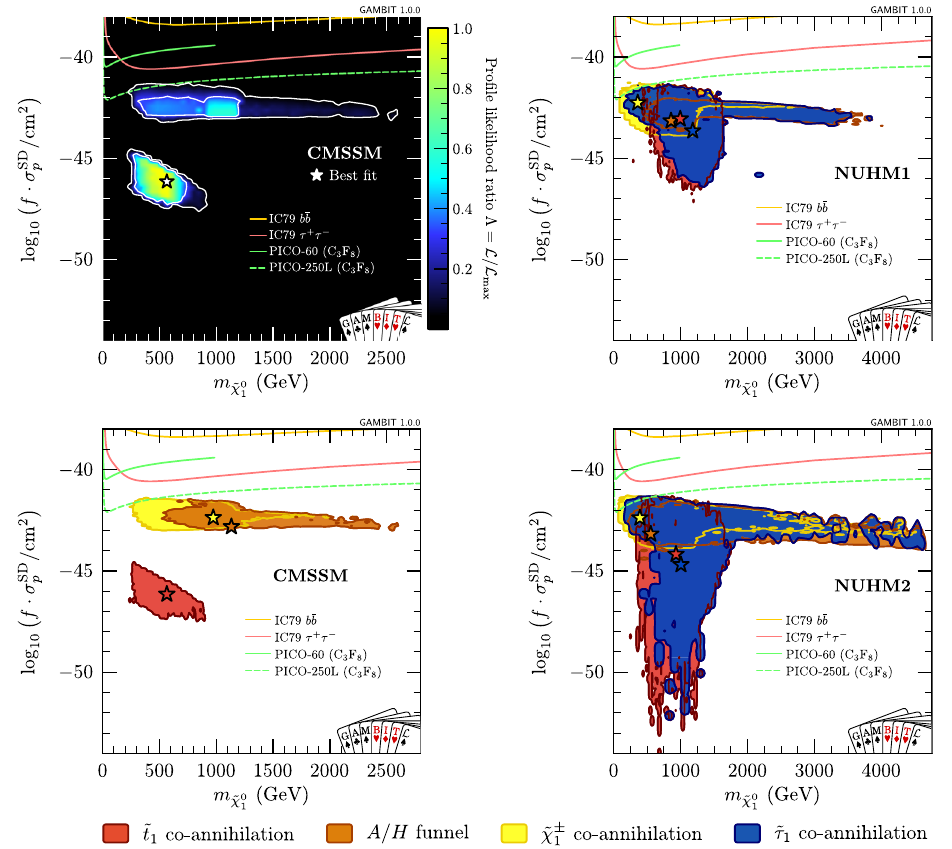
Fig. 20 The spin-dependent neutralino-proton cross-section. Upper left: Profile likelihood in the CMSSM. Bottom left: Colour-coding showstheactivemechanism(s)bywhichCMSSMmodelsavoidexceed- ing the observed relic density of DM, through either chargino co- annihilation,the A / H funnel,orstopco-annihilation.Topright:Colour- coded regions in the NUHM1, now also featuring stau co-annihilation